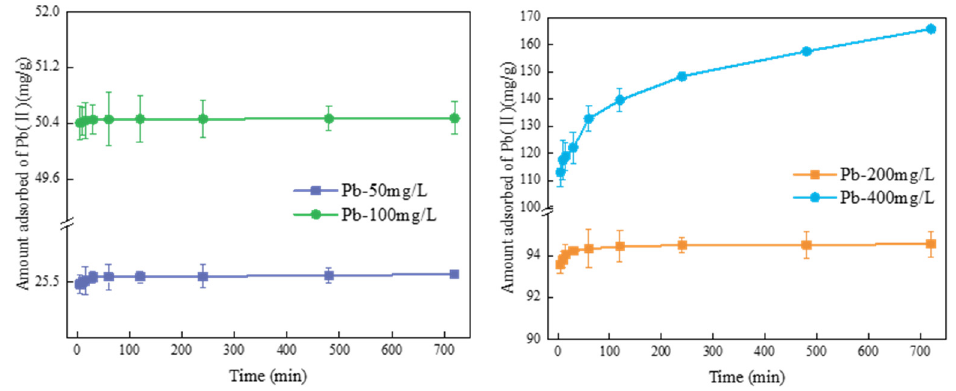
Figure 7. The effects of time and initial concentration on Pb(II) adsorption by FM-BC. Table 2. Comparison of sorption capacity of adsorbents for Pb(II).